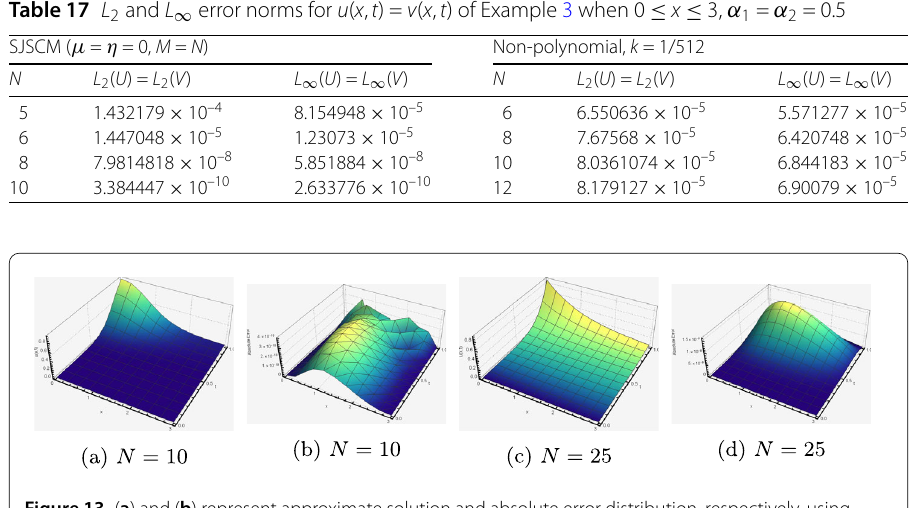
Figure 13 ( a ) and ( b ) represent approximate solution and absolute error distribution, respectively, using SJSCM. ( c ) and ( d ) represent approximate solution and absolute error distribution, respectively, using